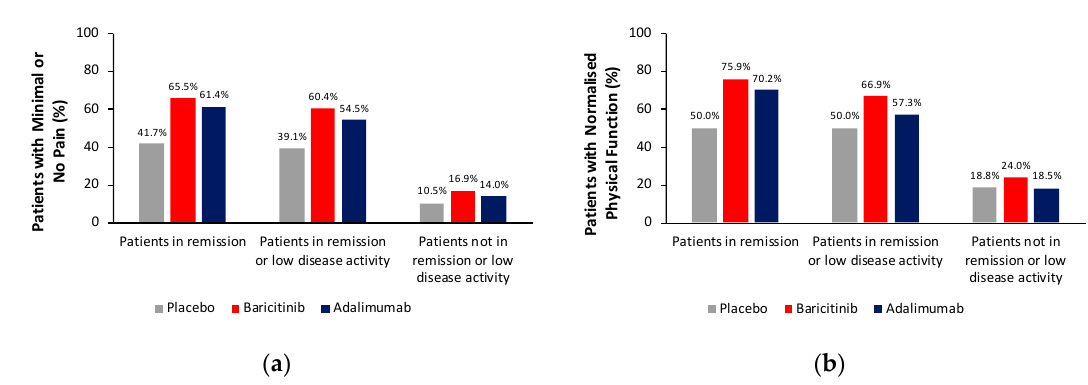
Figure 3. Patients from RA-BEAM with ( a ) minimal / no pain and ( b ) normalised physical function at week 24, by remission status. Proportions of patients from RA-BEAM with ( a ) minimal or no pain (pain VAS ≤ 10 mm) and ( b ) normalised physical function (HAQ-DI < 0.5) based on numbers of patients in remission (DAS28-ESR < 2.6): PBO + MTX n = 24, BARI + MTX n = 87, ADA + MTX n = 57; in remission or low disease activity (DAS28-ESR ≥ 2.6 and ≤ 3.2): PBO + MTX n = 46, BARI + MTX n = 154, ADA + MTX n = 110; and not in remission or low disease activity (DAS28-ESR > 3.2): PBO + MTX n = 276, BARI + MTX n = 266, ADA + MTX n = 156. One patient was missing from the BARI + MTX group and one from the ADA + MTX group for patients not in remission or low disease activity. For the pain analysis, the number of patients not in remission or low disease activity was PBO + MTX n = 276, BARI + MTX n = 210, ADA + MTX n = 120. ADA adalimumab, BARI baricitinib, DAS28-ESR Disease Activity Score for 28-joint count with erythrocyte sedimentation rate, HAQ-DI Health Assessment Questionnaire-Disability Index, MTX methotrexate, PBO placebo, VAS visual analogue